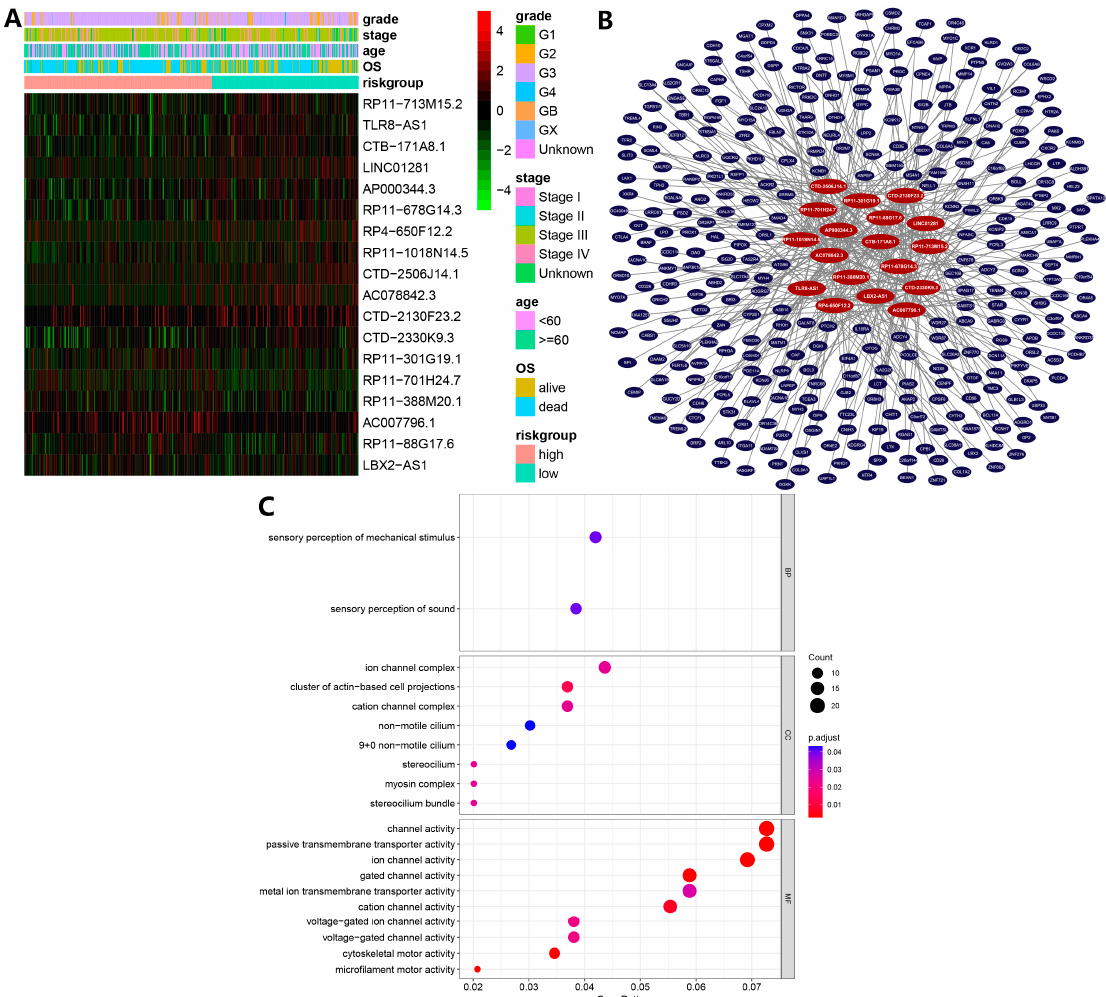
Figure 3. ( A ) Heatmap of ferroptosis-related long non-coding RNA (lncRNA) prognosis signature and clinicopathological manifestations. ( B ) Target mRNAs of the 18 lncRNAs predicted by Multi- Experiment Matrix (MEM) analysis. ( C ) Gene ontology (GO) enrichment analysis of target mRNAs of the 18 lncRNAs